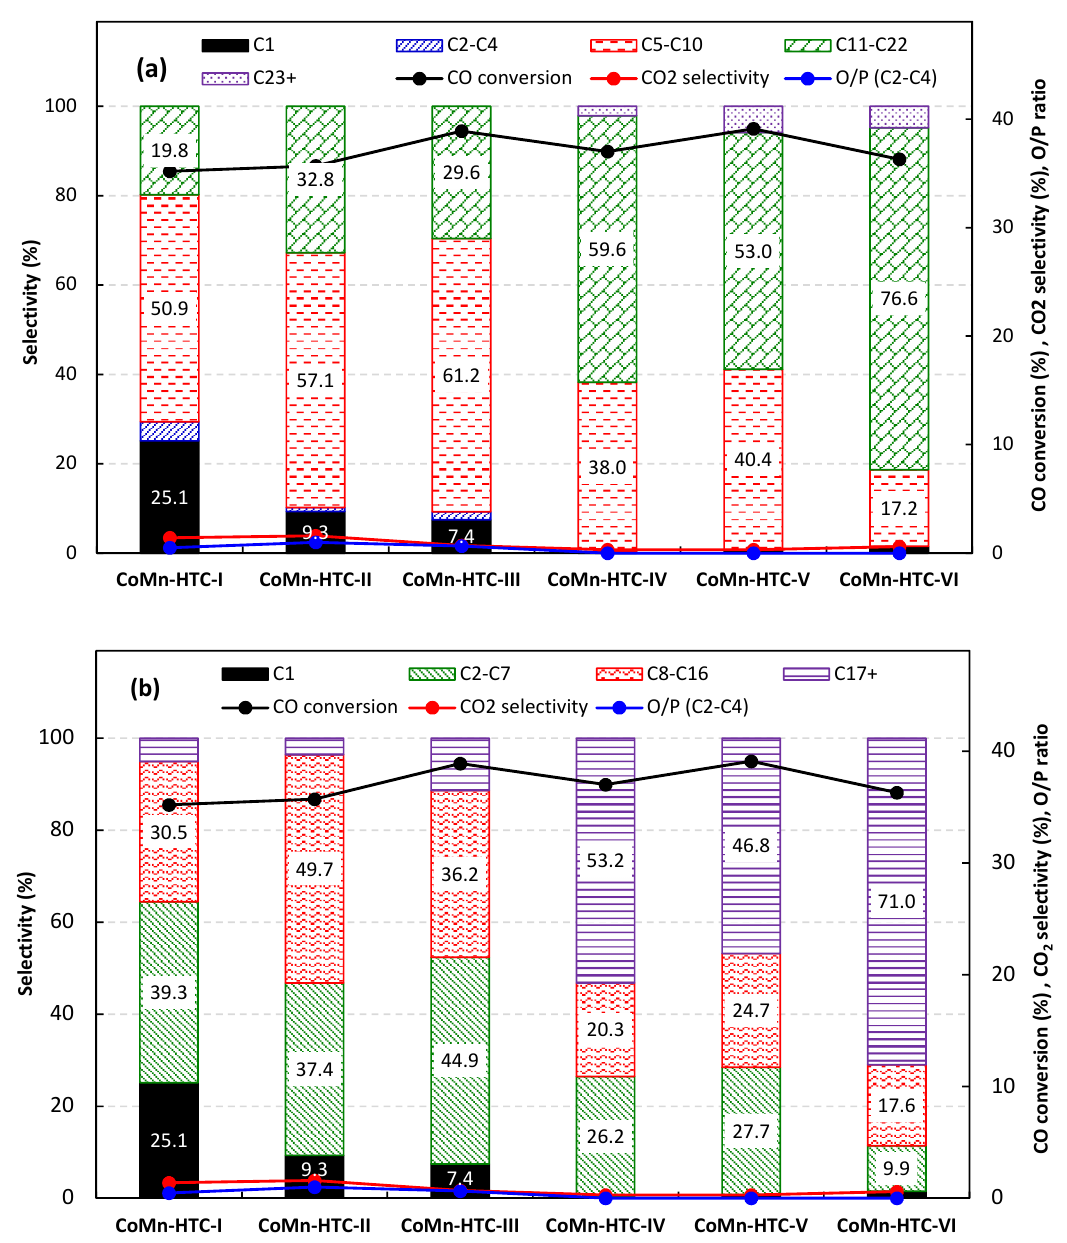
Figure 8. Product distribution in the Fischer–Tropsch (FT) reaction over CoMn-HTC catalysts: ( a ) gasoline range hydrocarbons (C 5 –C 10 ), and ( b ) jet fuel range hydrocarbons (C 8 –C 16 ). Reaction conditions: H 2 /CO = 2, 240 °C, 7 MPa, 6 h.